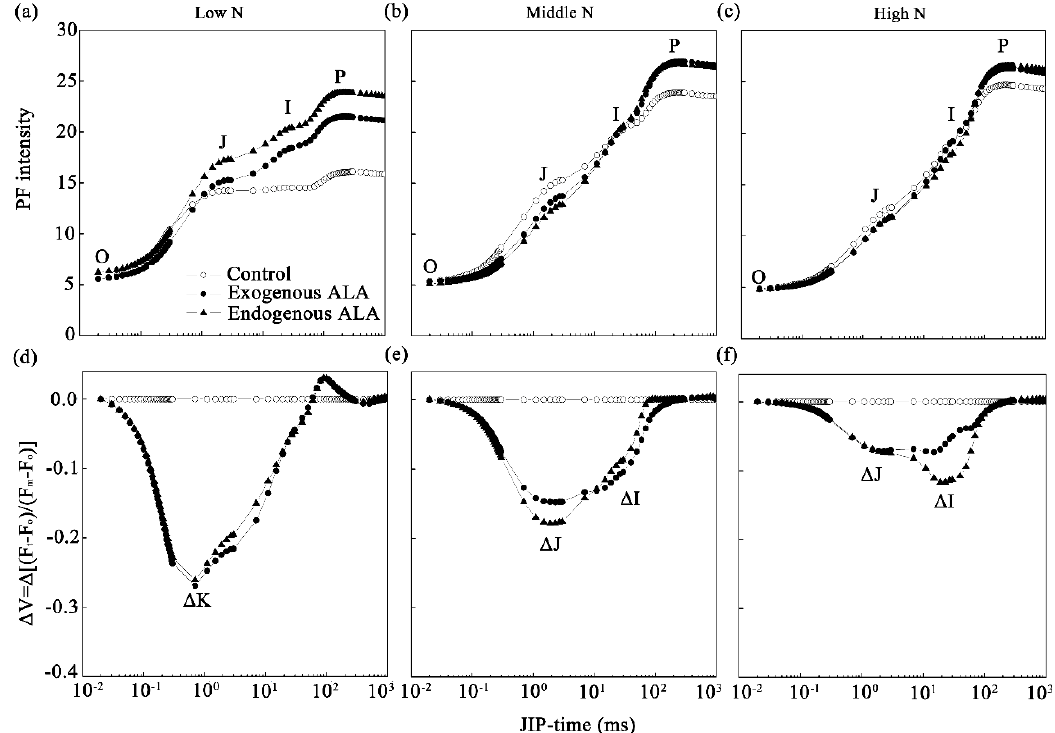
Figure 3. Changes in prompt fluorescence (PF) curves in exogenously-treated and endogenous ALA-overproducing canola leaves under low- ( a , d ), middle- ( b , e ), and high-N conditions ( c , f ). ( a – c ) PF curves plotted on a logarithmic time scale from 20 µ s to 1 s (JIP time). The steps O (at 20 µ s), J (at 2 ms), I (at 30 ms), and P (peak) are marked. Each curve is the average of 10 replicate measurements. ( d – f ) Variable fluorescence curves ( ∆ V = ∆ [(F t − F o ) / (F m − F o )]), which were constructed by subtracting the normalized (between the O step and P step) values of the PF recorded in wild-type (WT) canola. The feature peaks ∆ K, ∆ J, and ∆ I are